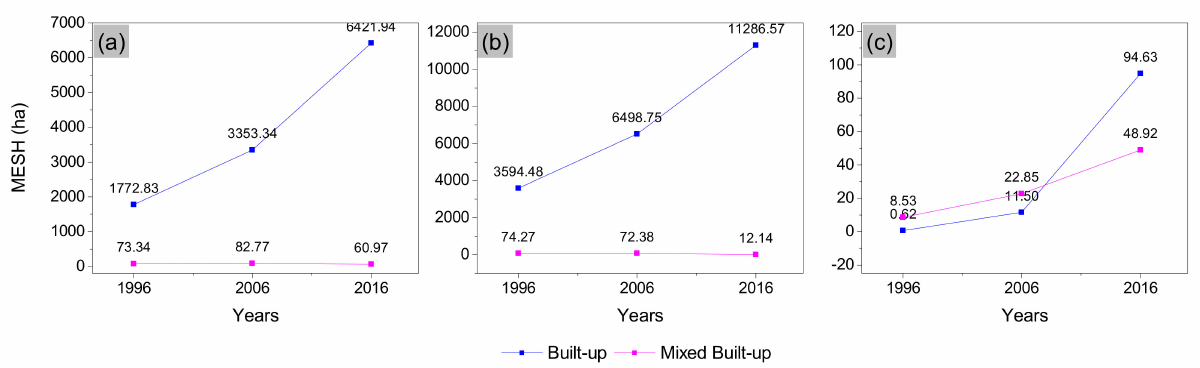
Figure 14. Class level MESH for the LULCs; ( a – c ) represent MESH for KMA, KMA-urban, and KMA-rural, respectively, in 1996, 2006, and